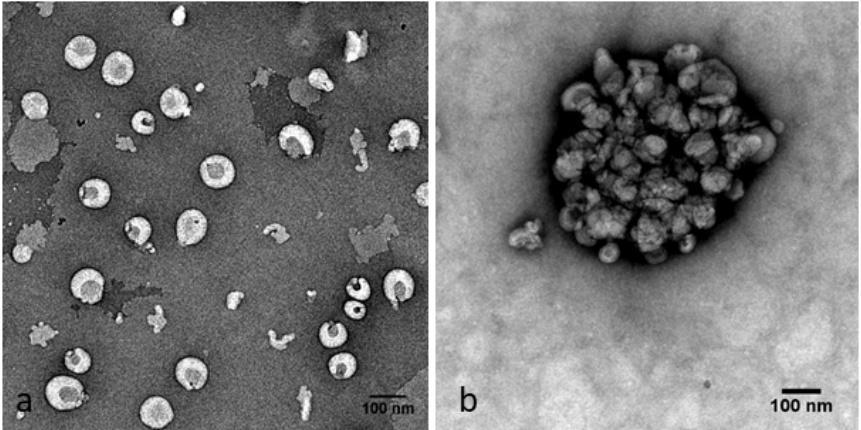
Figure 3. TEM images of ( a ) uncoated and ( b ) thiolated Lip-SeNPs. The latter show an irregular structure of the polymers on the surface of the Lip-SeNPs. The scale bars are 100 nm.